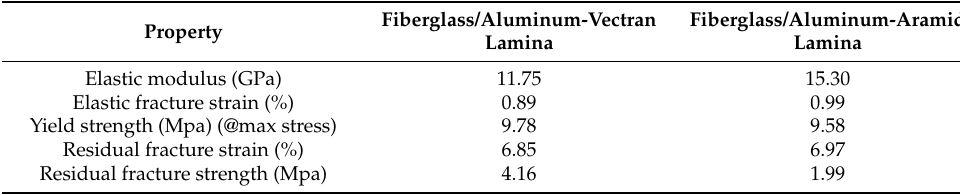
Table 2. Three-point bending mechanical properties of the hybrid